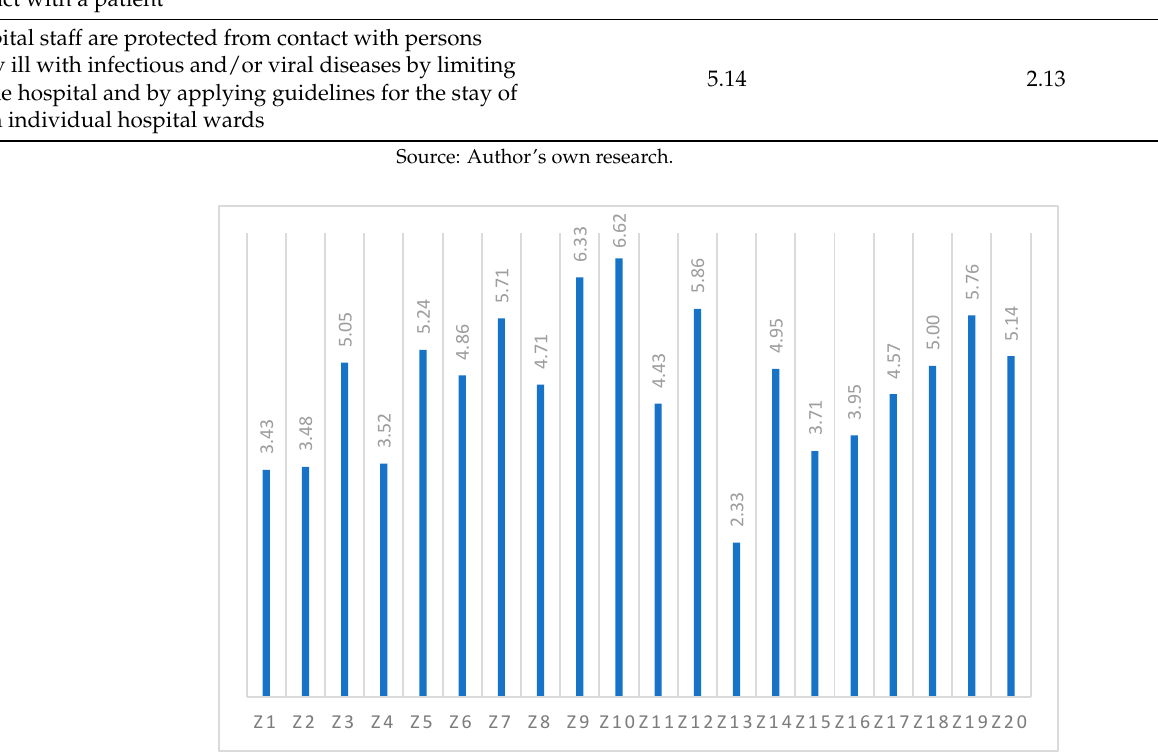
Figure 1. Level of quality assurance of health measures. Source: Author’s own research.